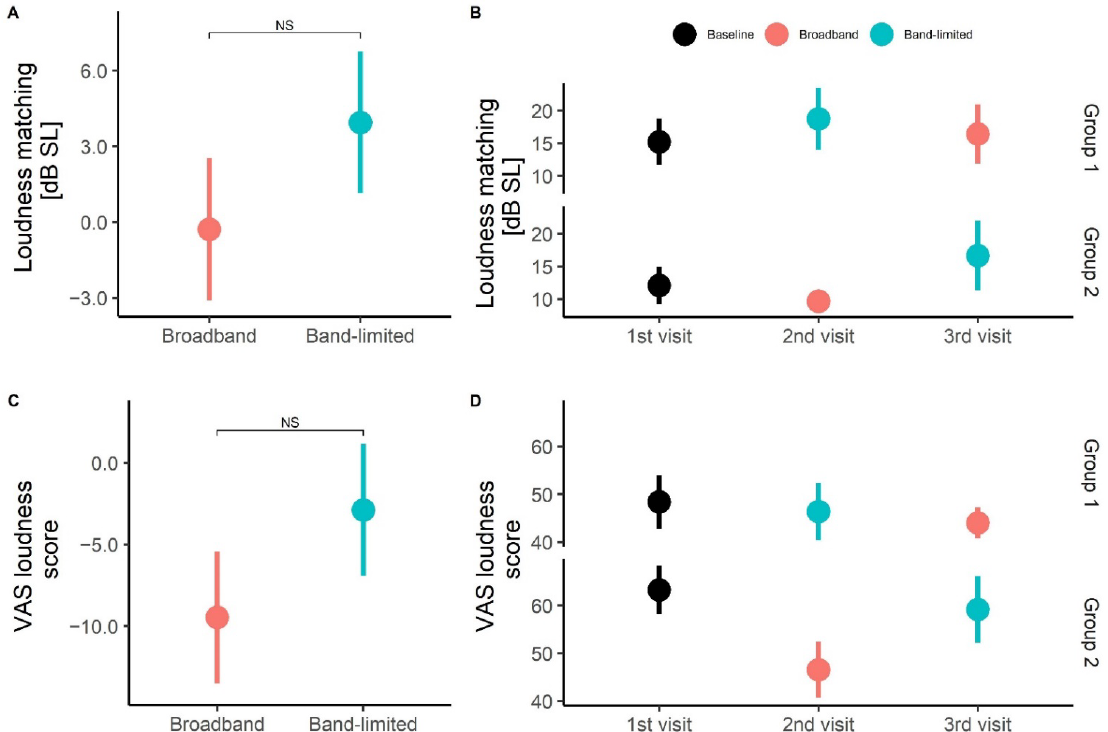
Figure 5. Tinnitus loudness. ( A ) Average change in tinnitus loudness matching after broadband and band-limited amplification from baseline. The data from groups 1 and 2 were pooled for both the broadband and band-limited conditions. Averages are presented as mean ± SEM. ( B ) Average tinnitus loudness matching at each visit subdivided into treatment groups. ( C ) Average change in VAS loudness score after broadband and band-limited amplification from baseline. The data from groups 1 and 2 were pooled for both the broadband and band-limited conditions. ( D ) Average VAS loudness score at each visit subdivided into treatment groups.